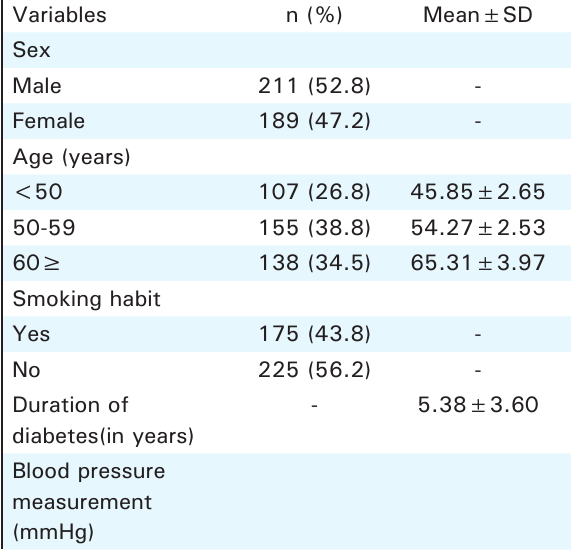
Table 1. Personal profile of the study